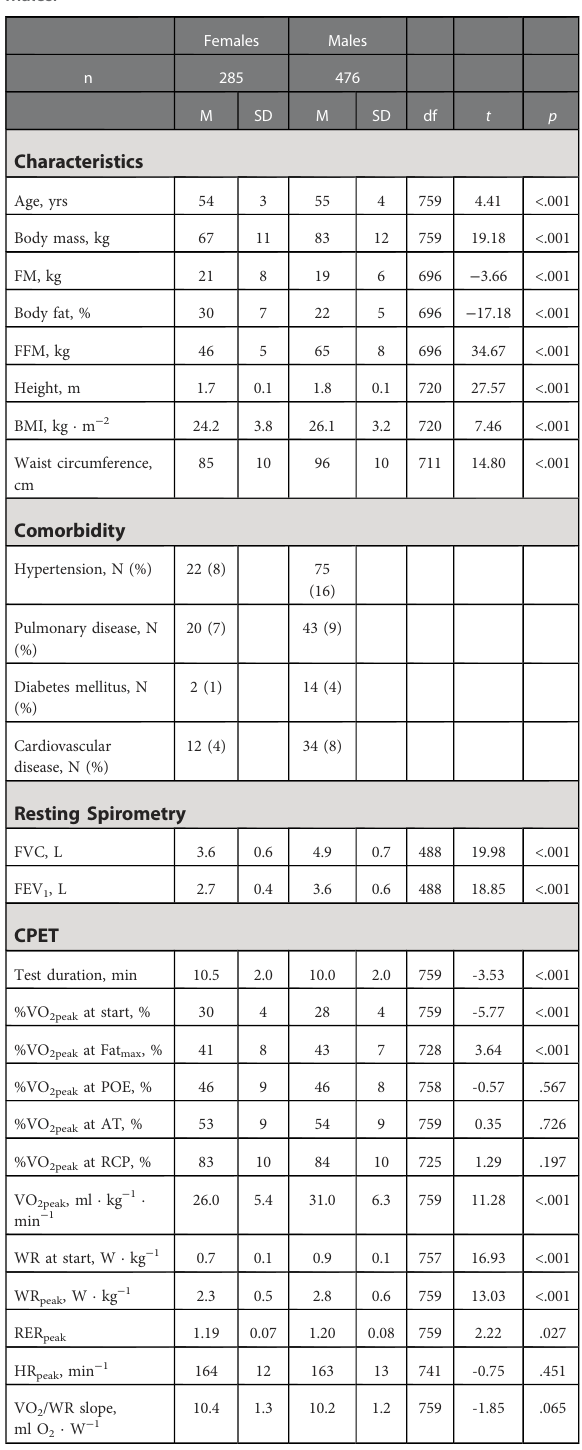
TABLE 2 Characteristics, comorbidity and main results of resting spirometry and cardiopulmonary exercise test (CPET) in females and